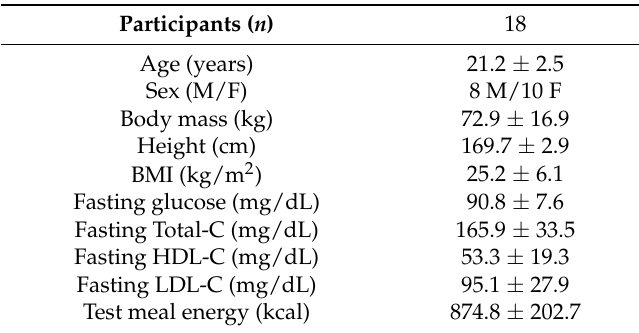
Table 1. Participant characteristics.